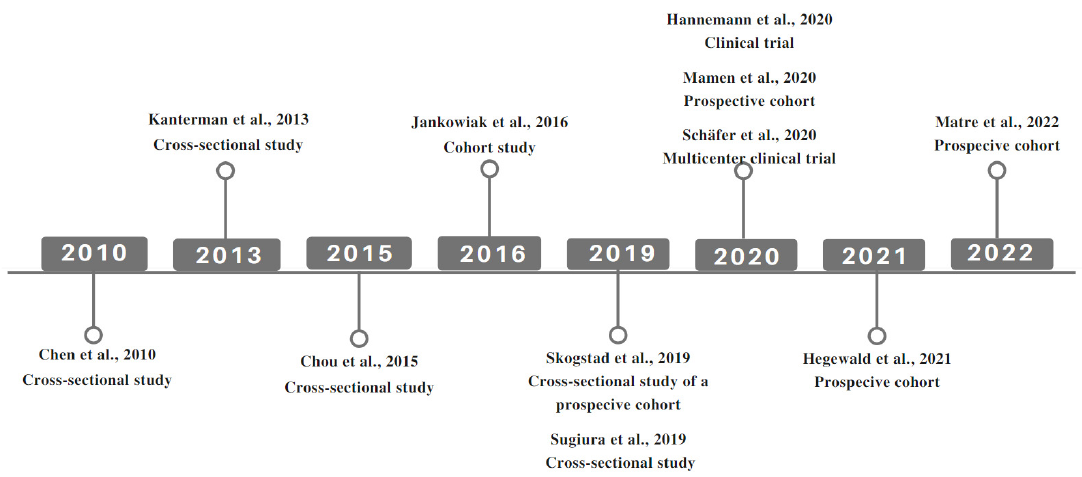
Figure 2. Timeline of publications and study types of articles included in this systematic review